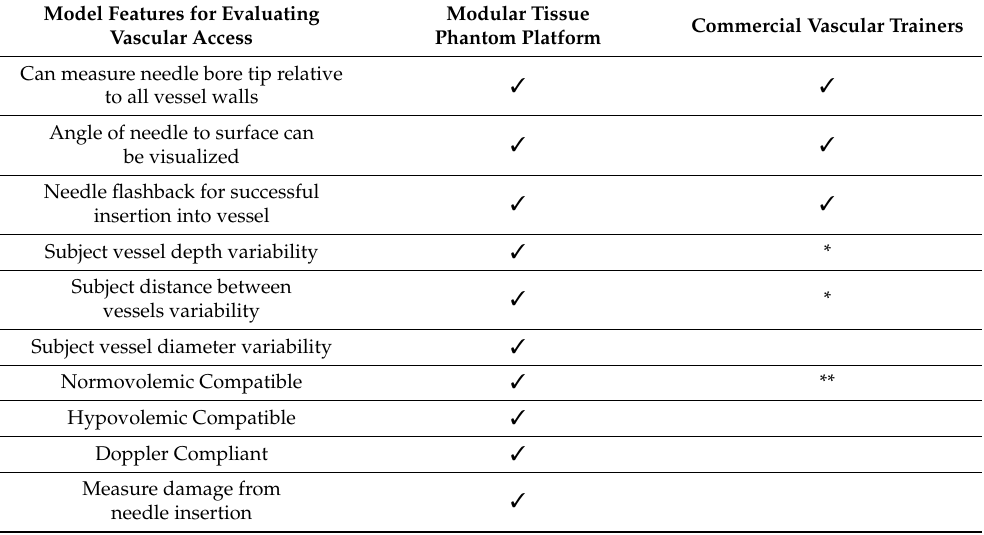
Table 2. Comparison of the modular tissue phantom platform vs. commercial vascular trainers. Checkmark indicates model can successfully perform. * Depths and distances between vessels vary across the most commercial phantoms but cannot be adjusted. ** Commercial trainers are likely normovolemic compatible but without pressure control, cannot